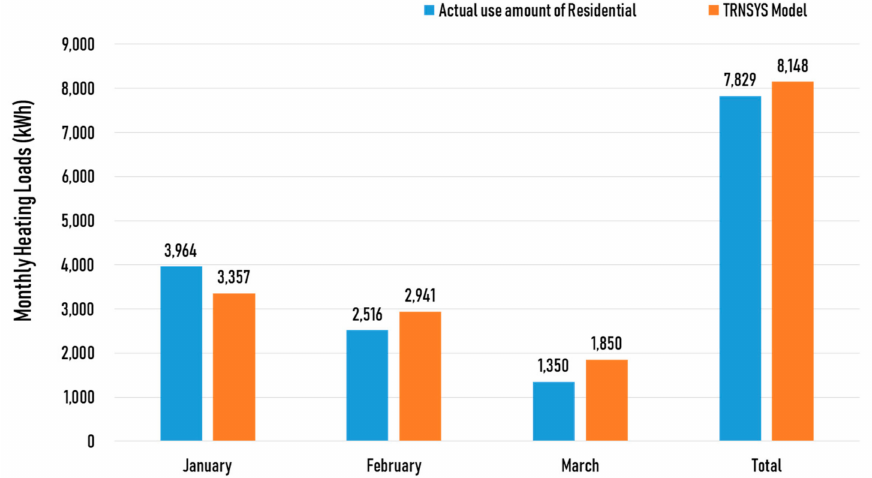
Figure 6. Comparison of load calculations between real measurement data and the